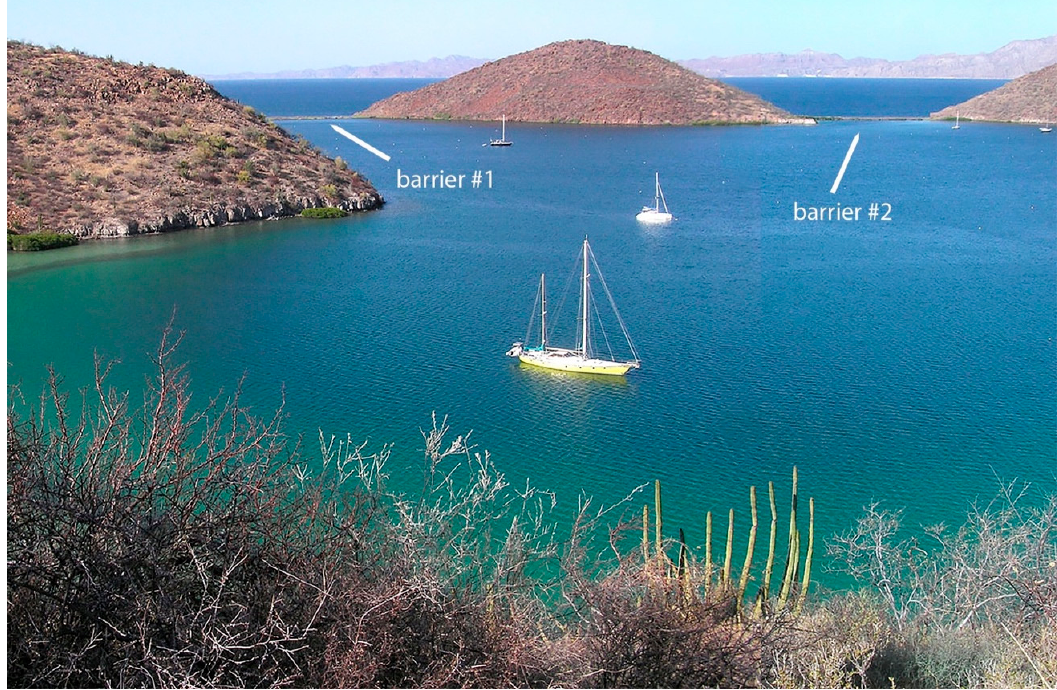
Figure 2. View east over the inner harbor at Puerto Escondido with Isla del Carmen on the horizon.